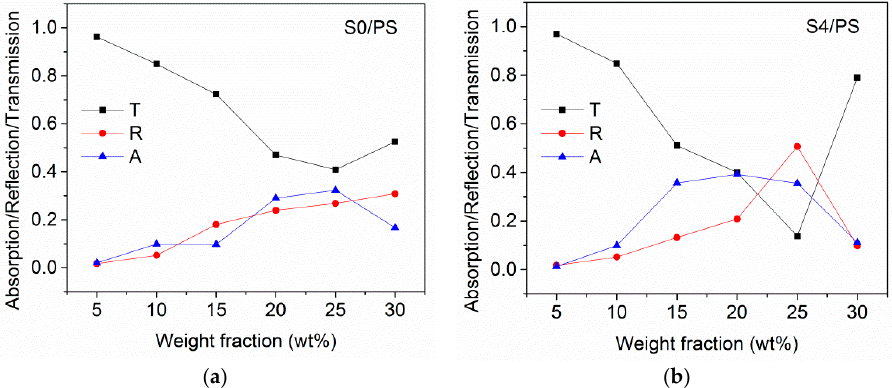
Figure 7. Transmission, absorption, and reflection of S0/PS ( a ) and S4/PS ( b ) composites at 3 GHz.